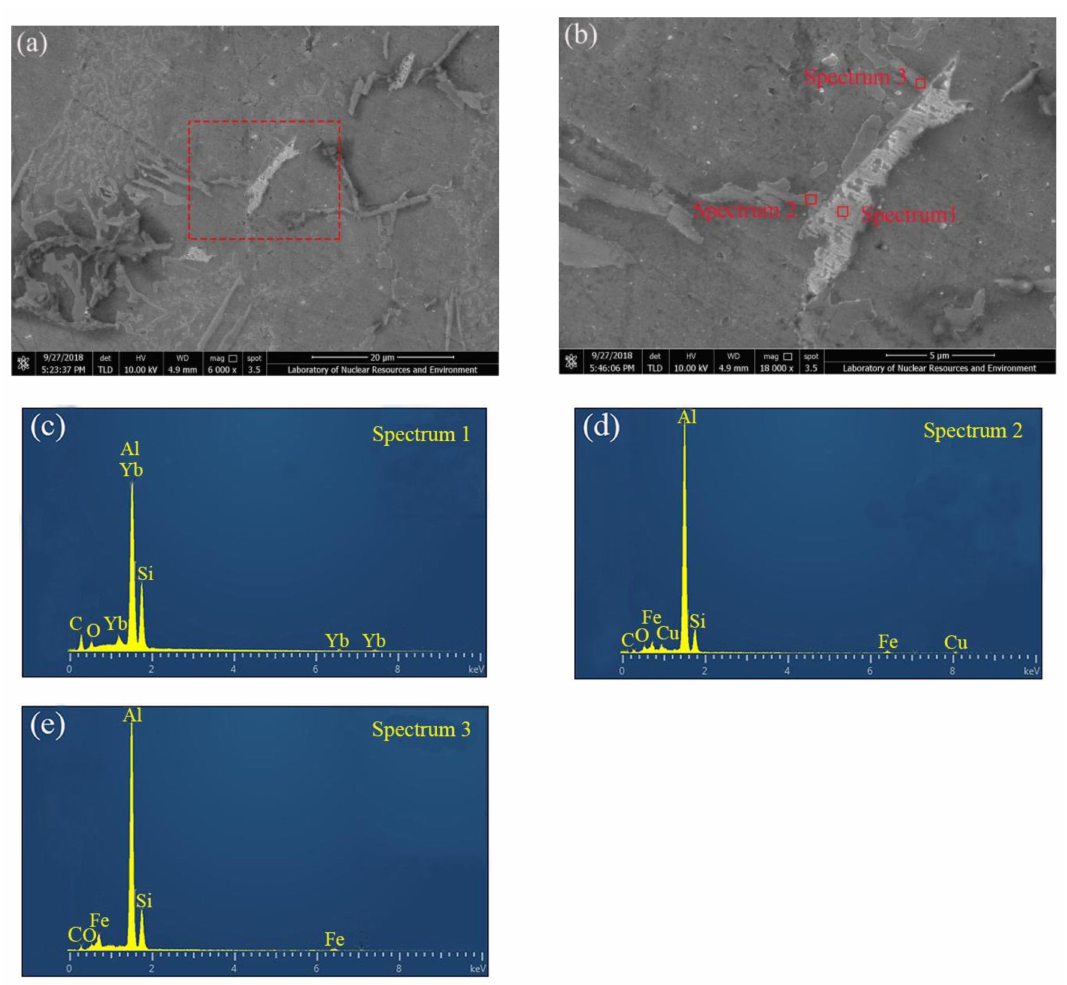
Figure 7. SEM images and EDS results of the alloy: ( a ) 0.8 wt % Yb; ( b ) the partial amplifying view of ( a ); ( c ) EDS of point 1; ( d ) EDS of point 2; ( e ) EDS of point